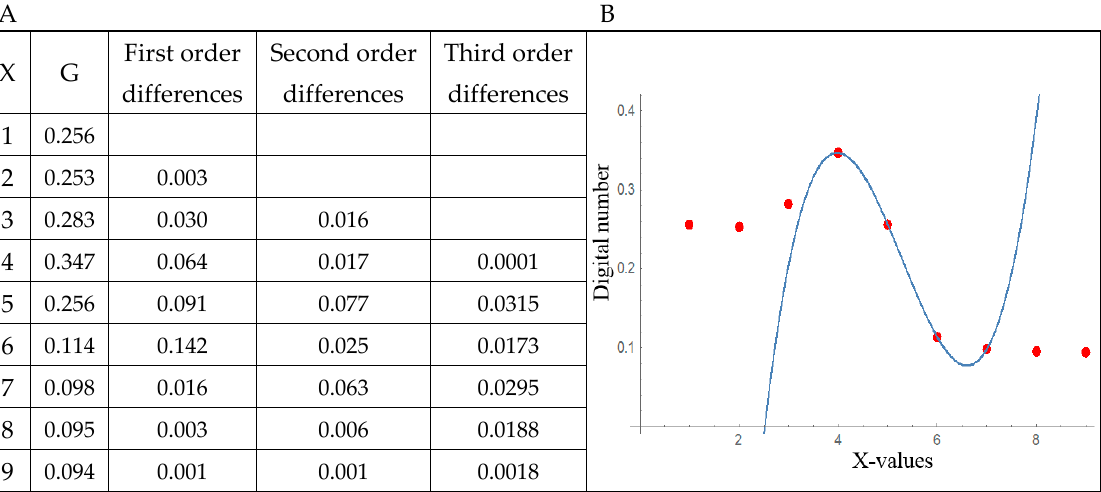
Figure 3. ( A ) Example using absolute values of a divided differences table and with X = 5 as the initial shoreline pixel. Values in red are compared in the iterative procedure explained in Section 3.2 to calculate the stencil for the interpolating polynomial, choosing in each column the maximum for such red values. ( B ) Interpolating the polynomial using the selected four-pixel stencil.